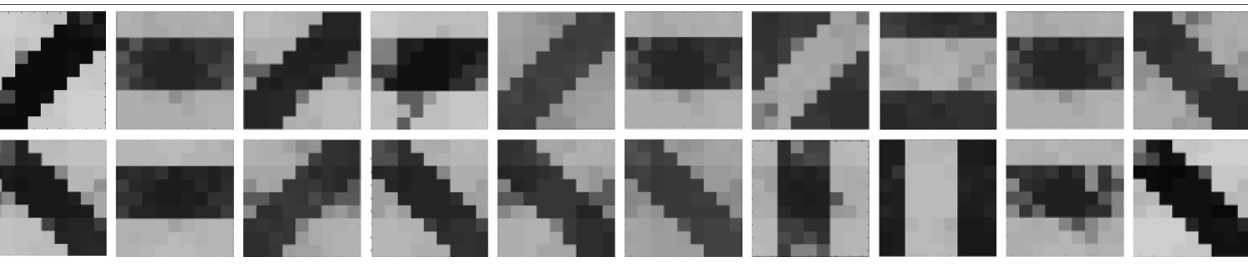
Table 4A | Summary of 20 simulations of orientation selective cell with same initial conditions but different random-inside-epoch order of input